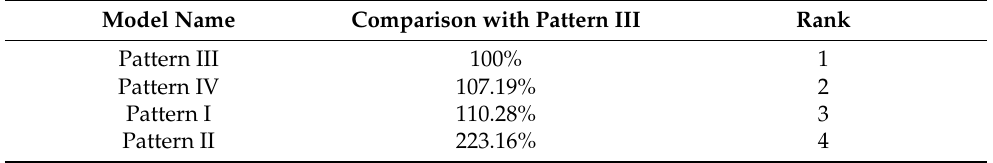
Table 12. Cross-sectional comparison based on Pattern I for a 20 MB file